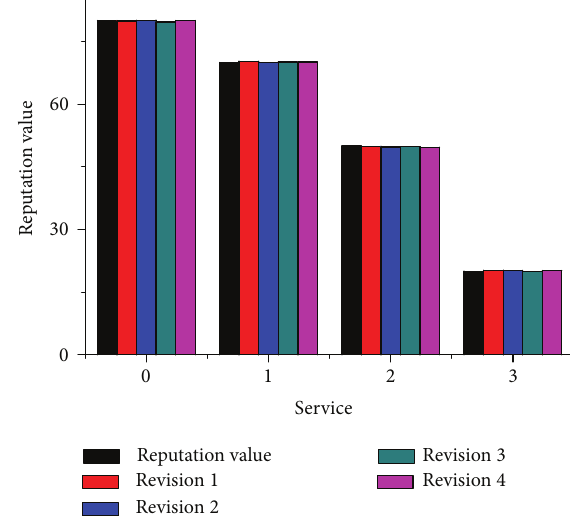
Figure 8: Four rounds of revised